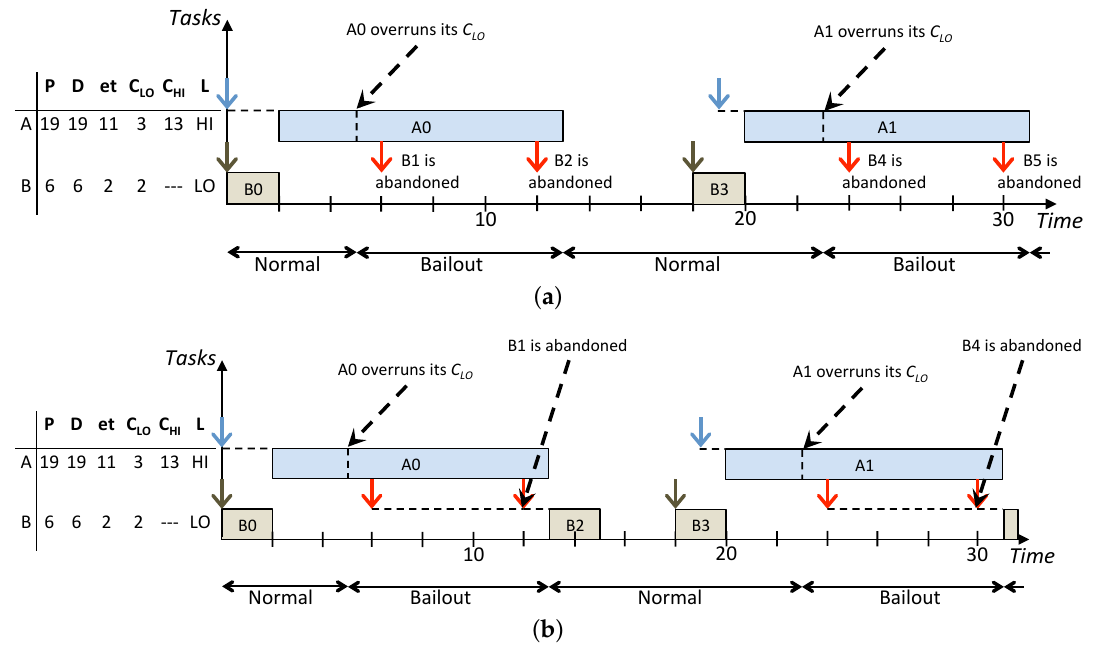
Figure 3. Comparison between BP and LBP: LBP schedules more LO jobs than BP: ( a ) BP abandons all LO jobs released in Bailout mode; and ( b ) LBP rescues the LO jobs B 2 and B 5, while B 1 and B 4 are abandoned after they miss their